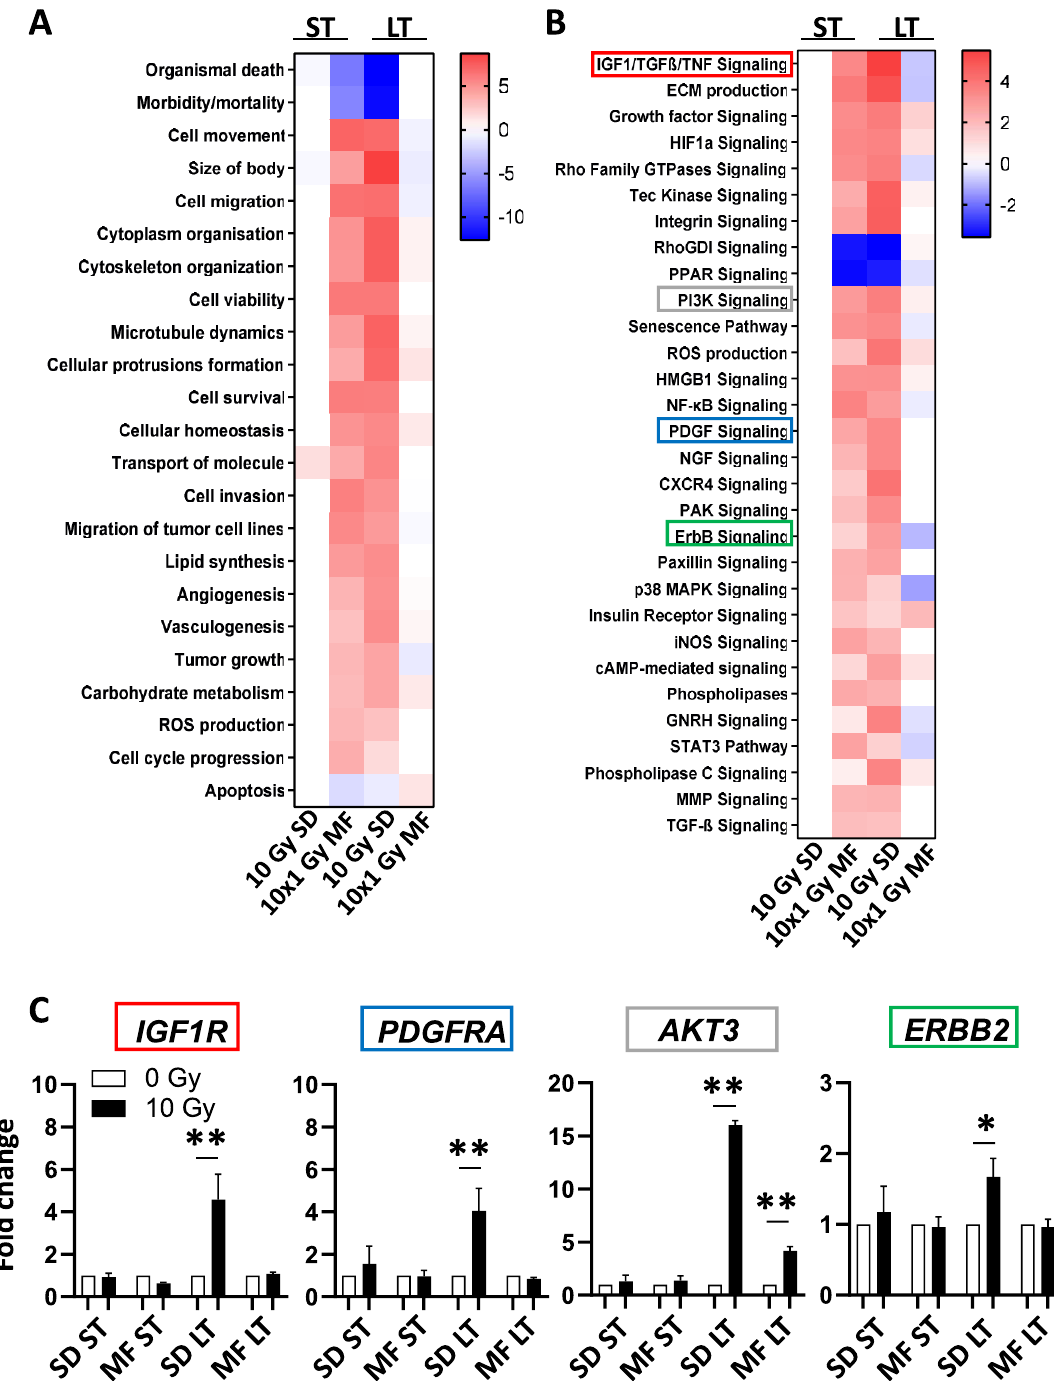
Figure 2. Single-dose irradiation increases the expression of molecular targets. Upregulation (red) or downregulation (blue) of ( A ) cellular functions and ( B ) molecular pathways in PC3 cells at 24 h (short-term, ST) or 2 months (long-term, LT) after a single dose of 10 Gy (10 Gy SD) or a multifractionated regimen with 10 fractions of 1 Gy (10 × 1 Gy MF) determined with the Ingenuity Pathway Analysis (IPA) software (Qiagen). ( C ) Normalized gene expression of molecular targets in PC3 cells under indicated conditions. Results show mean ± STDEV (n = 3, *P < 0.05, **P < 0.01, Student’s